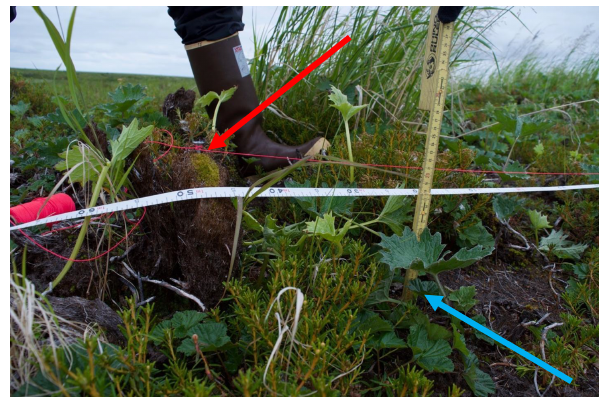
Figure 2. An example burn depth measurement from the surviving top of a Dicranum spp. moss patch (red arrow; pink string) to the top of the soil (blue arrow) in a burned transect. Transect tape was used to measure the distance between the moss